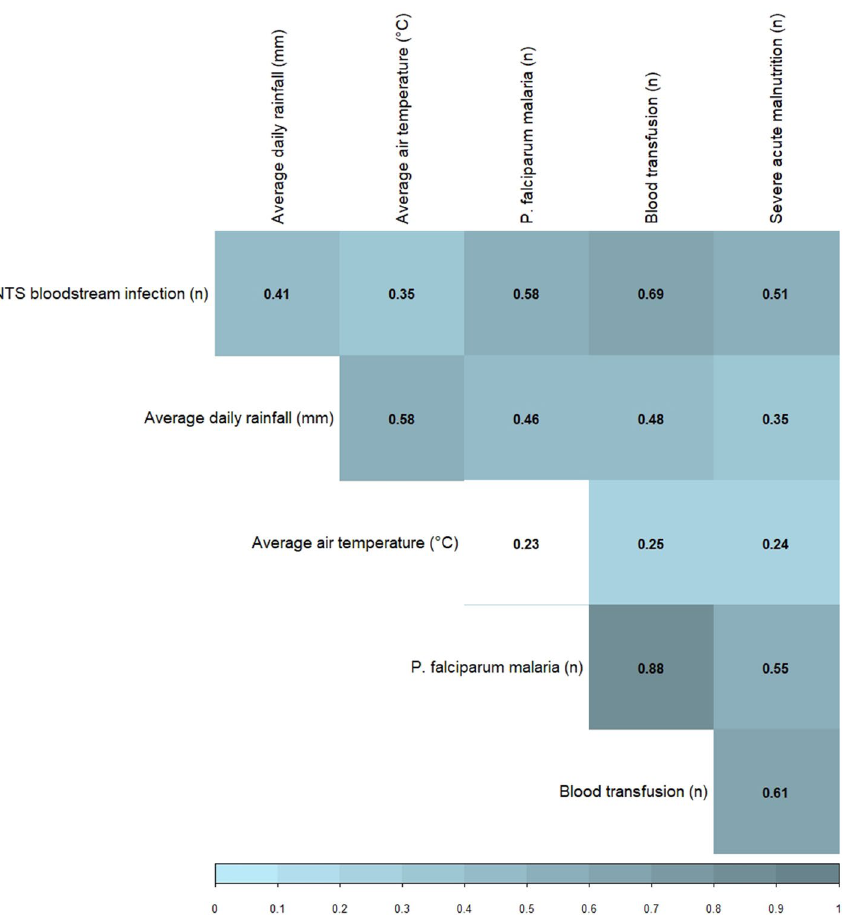
Figure 3. Spearman correlation matrix of association between the monthly number of non-typhoidal Salmonella (NTS) bloodstream infections in children under five years old, its environment- factors and host- associated factors (n months = 72, from which two months without data available for severe acute malnutrition). Only the correlation between temperature and Plasmodium (P.) falciparum malaria was not significant (p-value > 0.05, non-colored